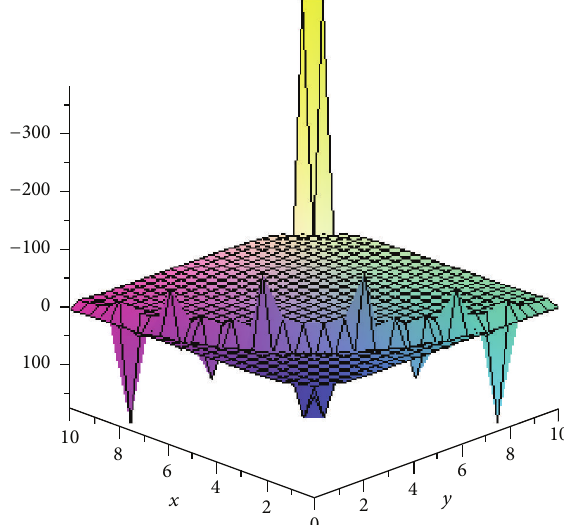
Figure 3: The periodic wave solution 𝑢 3 with 𝑒 1 = −1 , 𝑎 = 𝑏 = 𝑐 = 𝑘 = 1 = 1 , 𝑡 = 0.5 , and 𝛼 = 1/2 .